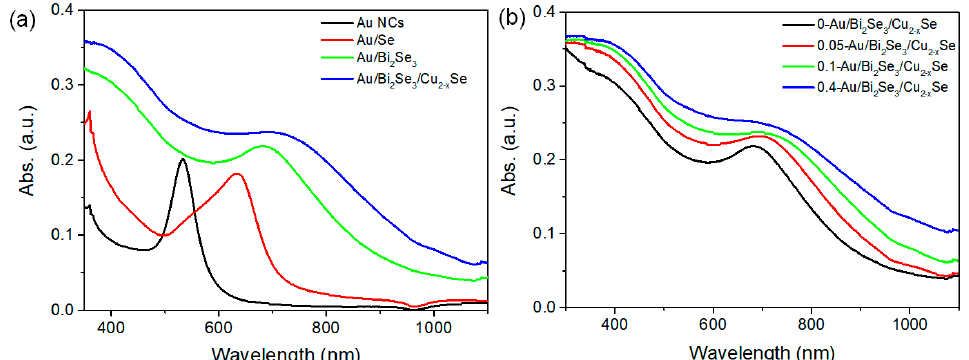
Figure 4. ( a ) UV–Vis absorption spectra of as-synthesized Au NCs, Au/Se, Au/Bi 2 Se 3 and Au/Bi 2 Se 3 /Cu 2-x Se nanoparticles. ( b ) UV–Vis spectra of Au/Bi 2 Se 3 /Cu 2-x Se nanoparticles with different amount of Cu 2-x Se, and the added Cu 2+ concentrations are 0.05, 0.1 and 0.4 M, respectively. To evaluate the PEC water splitting performance of the obtained Au/Bi 2 Se 3 /Cu 2-x Se hybrids, pure Bi 2 Se 3 , Au/Bi 2 Se 3 and Au/Bi 2 Se 3 /Cu 2-x Se NPs are loaded onto FTO working ison purposes, all samples have the same mass of corresponding components. Typical lin-